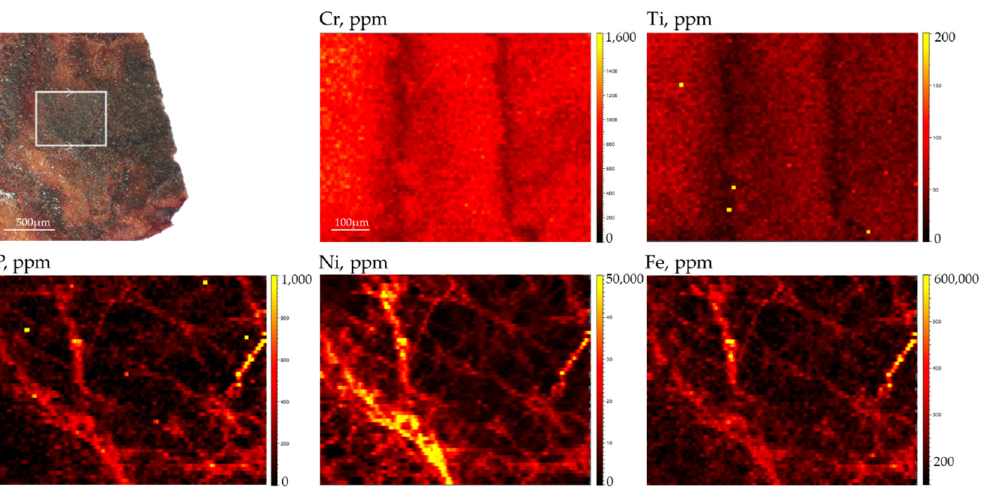
Figure 5. Quantitative LA-ICP-MS distribution maps of Cr, Ti, P, Ni, Fe within an olivine crystal of the Mineo pallasite. The image on the top left indicates the area where the maps were acquired and the direction of the acquisition. The color-scale is relative to the parts per million of each element.